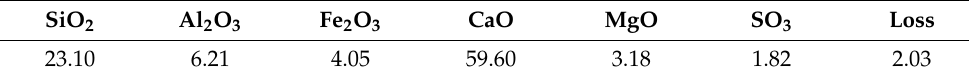
Table 2. The chemical composition of cement